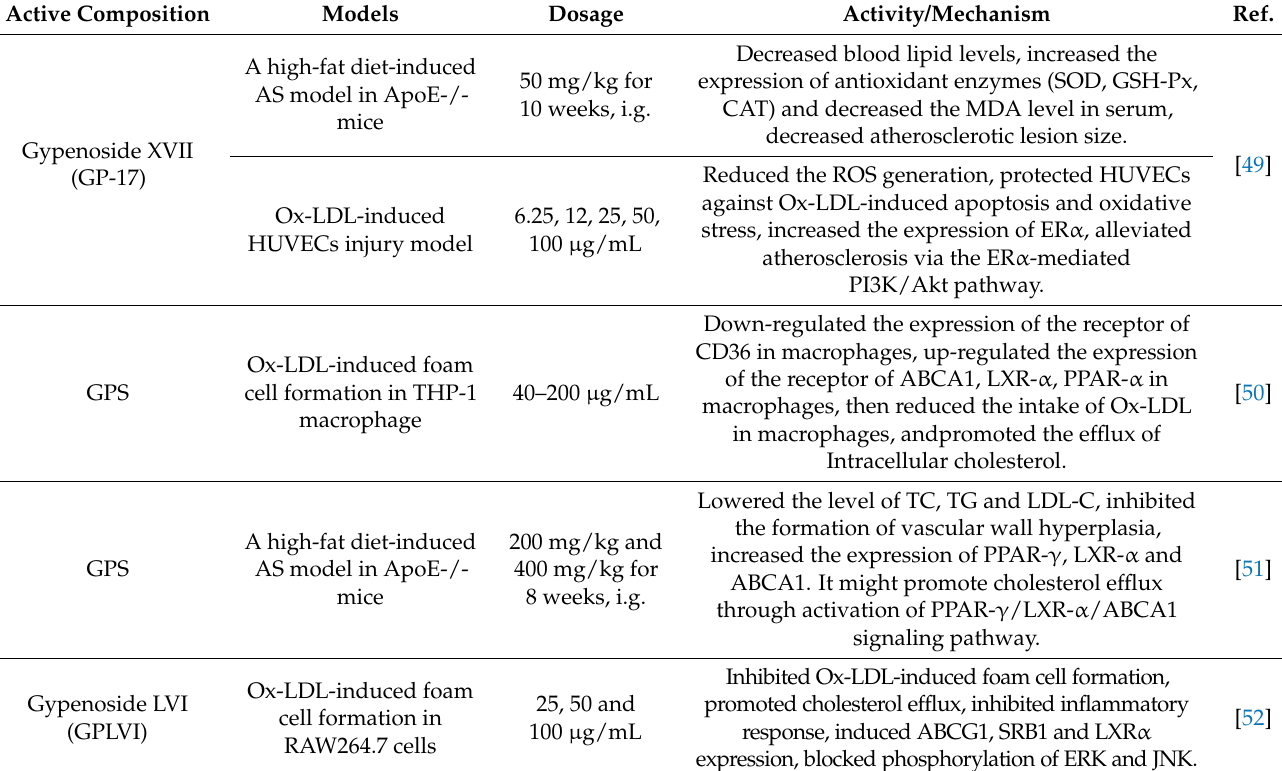
Table 2. Anti-atherogenic effect of